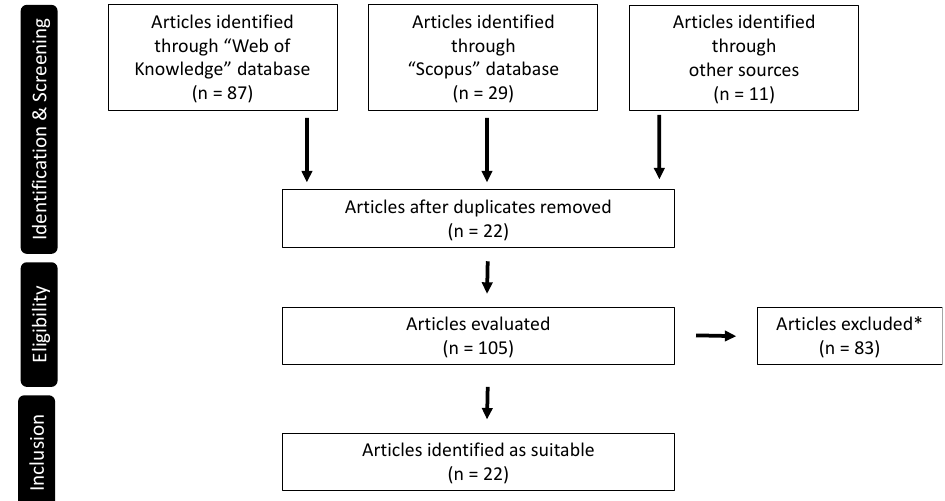
Figure 1. PRISMA workflow of the article selection process for the identification of suitable articles to be included in our review analysis. * Exclusion criteria is defined in the Methods section.